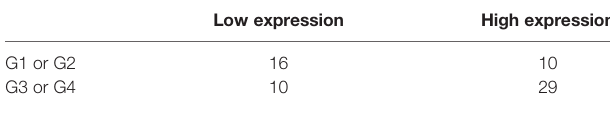
TABLE 4 | Contingency table for expression of ERAP2 and tumor grade in